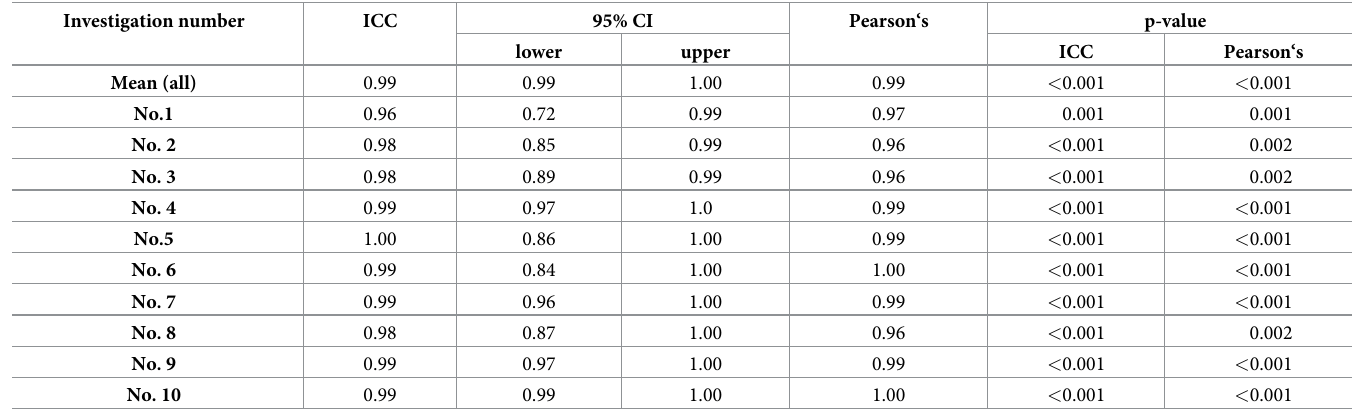
Table 2. ICC calculation and Pearson’s score for both investigators for each of the ten investigations. Investigation